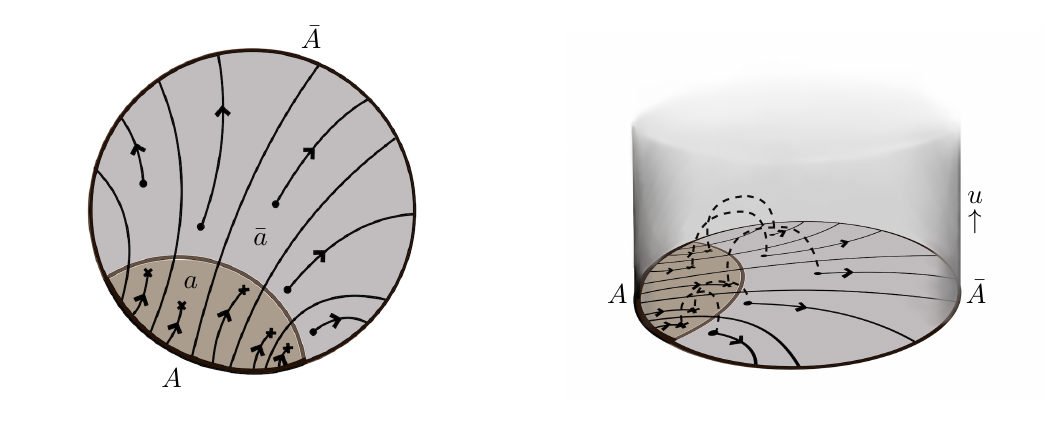
Figure 2 . Thread representation of the max flow associated to a simply connected boundary region (left). The crosses represent sinks of threads while the dots represent sources. Quantum threads are thus naturally oriented objects. From the global perspective, they are seen to jump across the minimal surface via quantum tunneling. This process can be intuitively understood in double holographic models (right), where the quantum threads are still continuously connected through the an emergent coordinate u . In this context, the sinks and sources arise by a projection of a divergenceless field into a lower dimensional